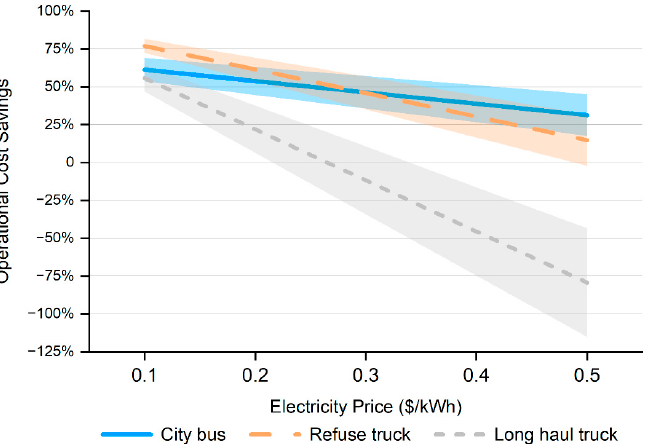
Figure 2. Impact of electricity price on the operational cost savings of MD/HD battery electric vehicles in comparison to diesel versions of these vehicles.